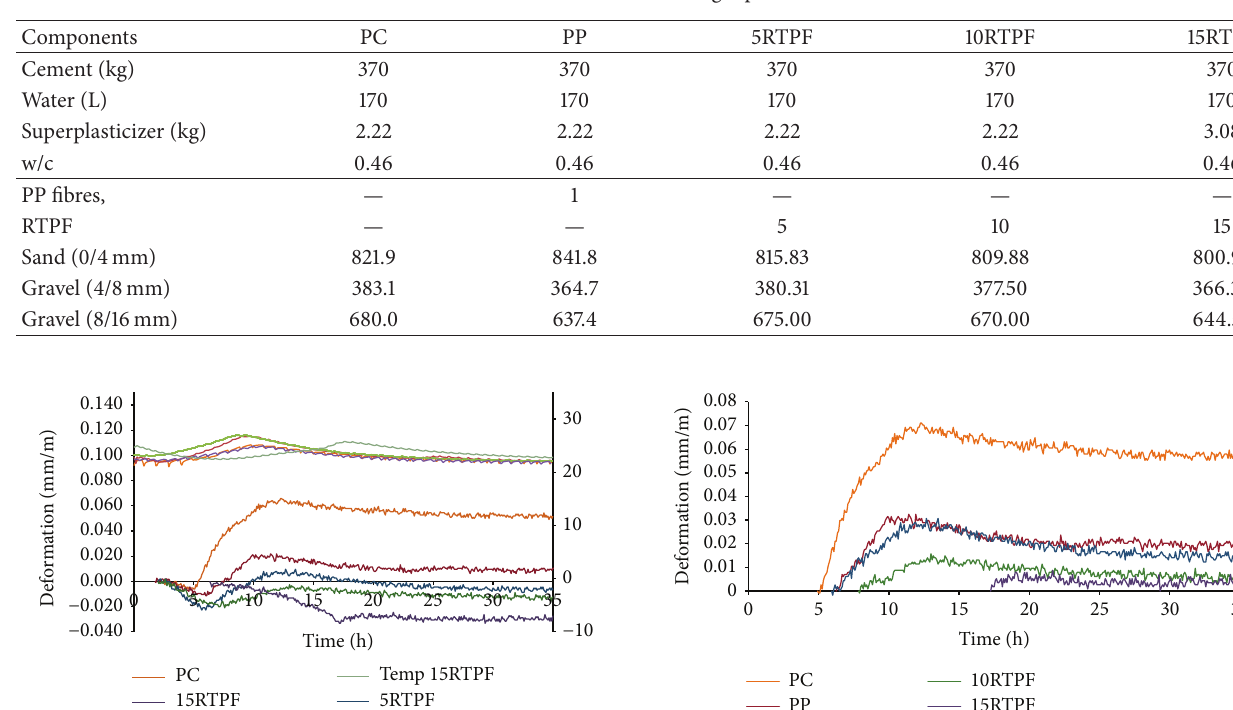
Table 3: Concrete mix design, per m 3 .